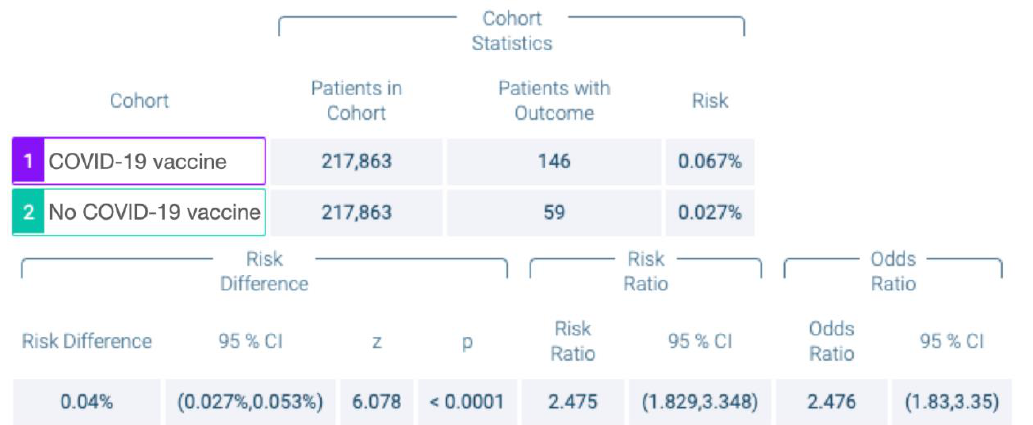
Figure 3. Number of patients with and without COVID-19 vaccination and risk of onset of oral li- planus (OLP)/oral lichenoid lesions (OLL) within 6 chen planus (OLP)/oral lichenoid lesions (OLL) within 6 days.